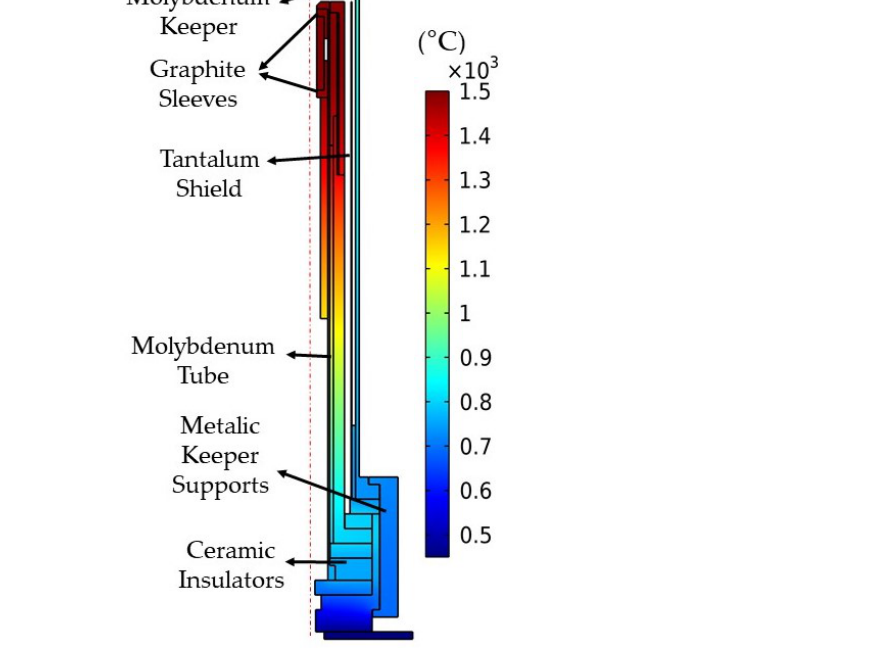
Figure 10. Temperature distribution within novel coaxial–heater hollow cathode. Table 1. Required heater power inputs for different cathode